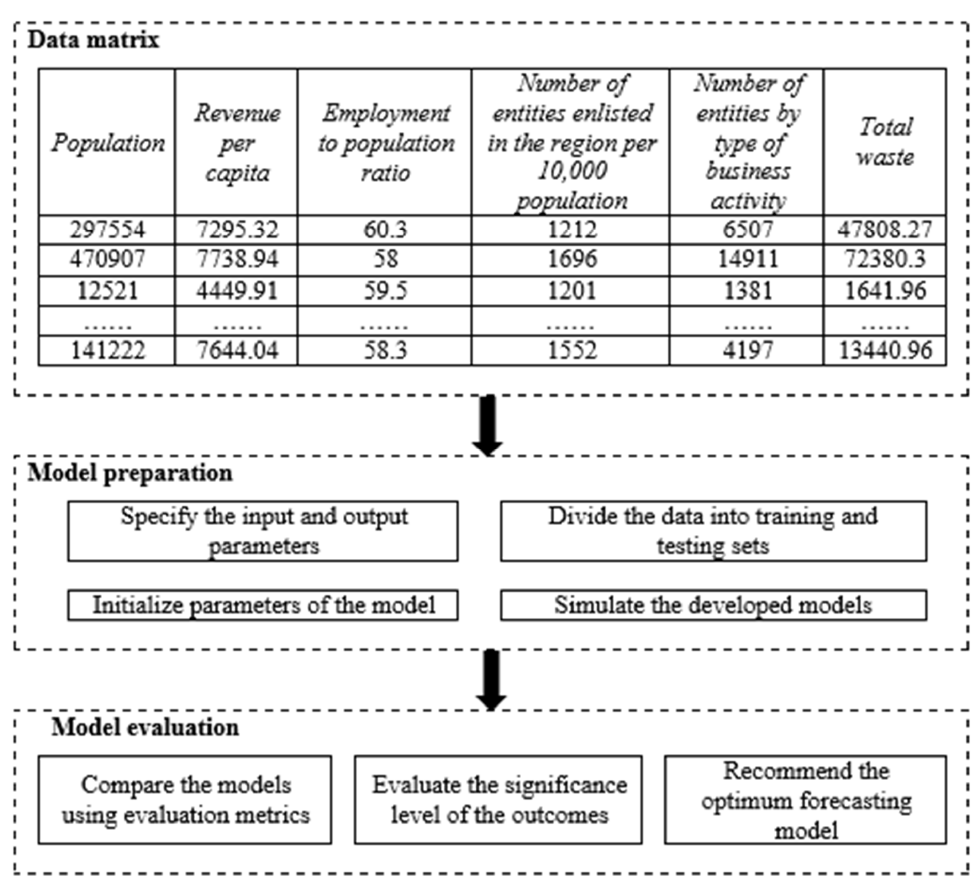
Figure 4. Components of the proposed framework.